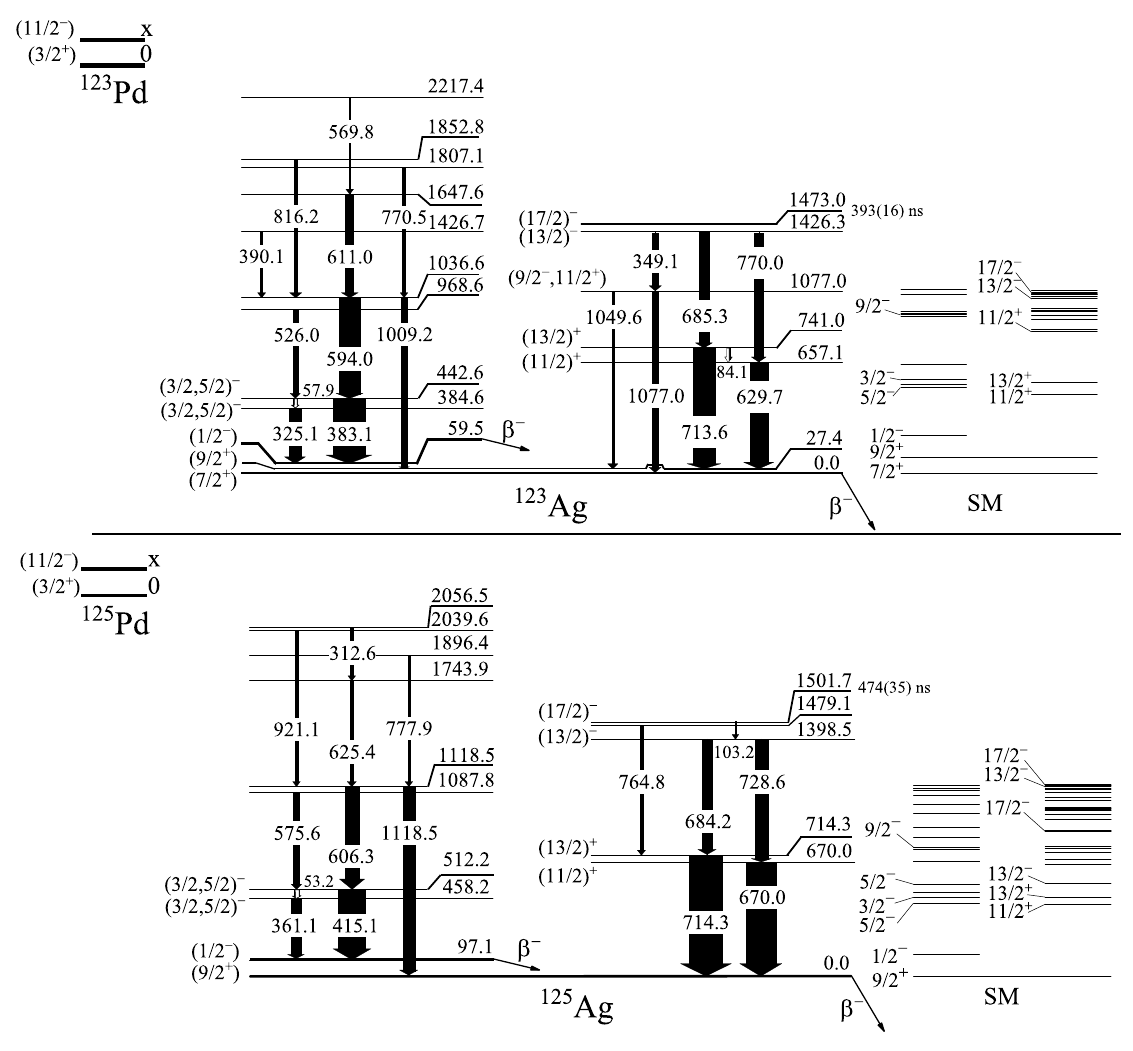
Figure 1. Partial level schemes of 123 Ag (upper) and 125 Ag (lower) presented in Ref. [15]. Levels predicted by shell-model (SM) calculations are shown on the right-hand side of each level scheme for comparison. Copyright (2019), with permission from the American Physical